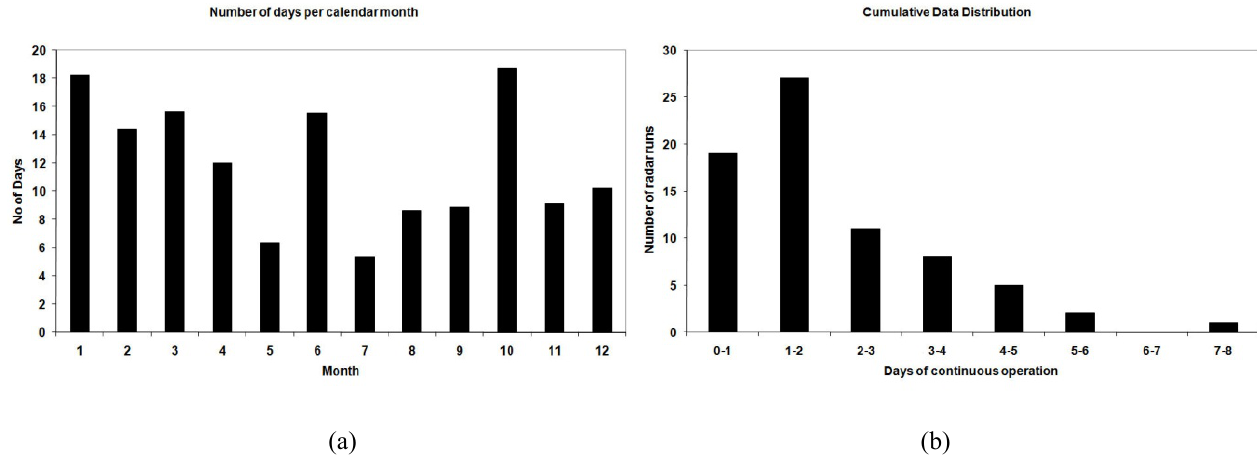
Fig. 1. The Arecibo ISR electron density profile measurements used in the present study: (a) distribution of observation days per month per calendar year over a period of 14 years, and (b) distribution of ISR continuous operation intervals in